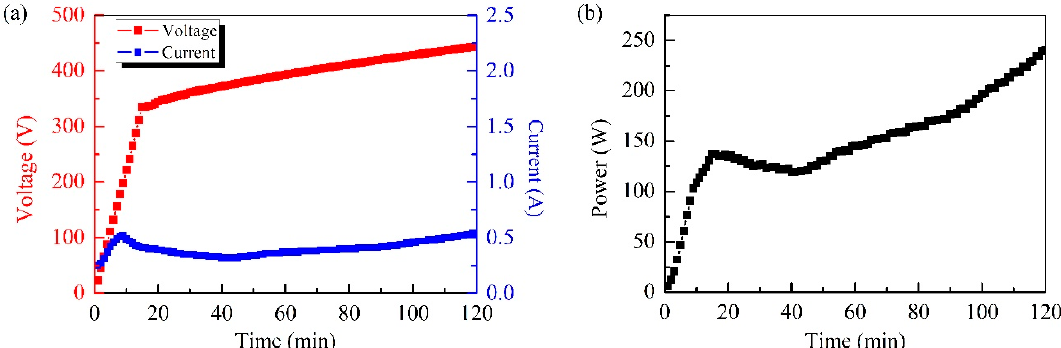
Figure 4. ( a ) Voltage–time curve, current–time curve, and ( b ) power–time curve during the self-adaptive plasma electrolytic oxidation processing of aluminum alloys.